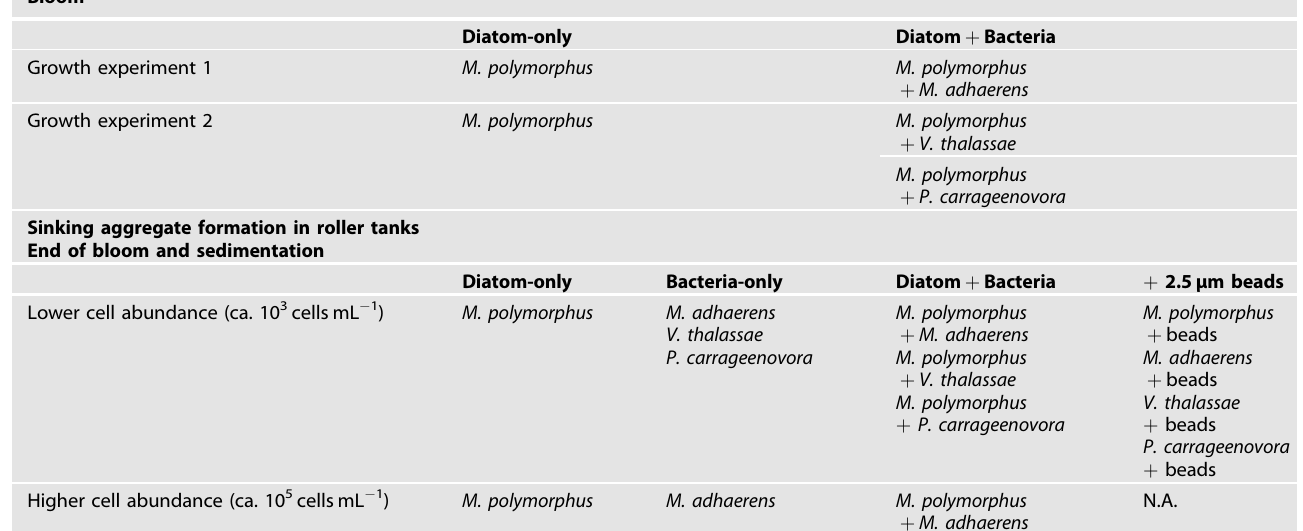
METHODS Diatoms and bacterial isolates